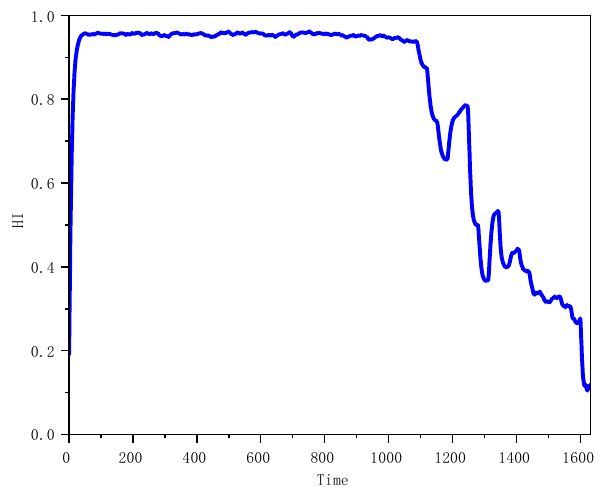
Figure 6. Bearing life prediction curve.